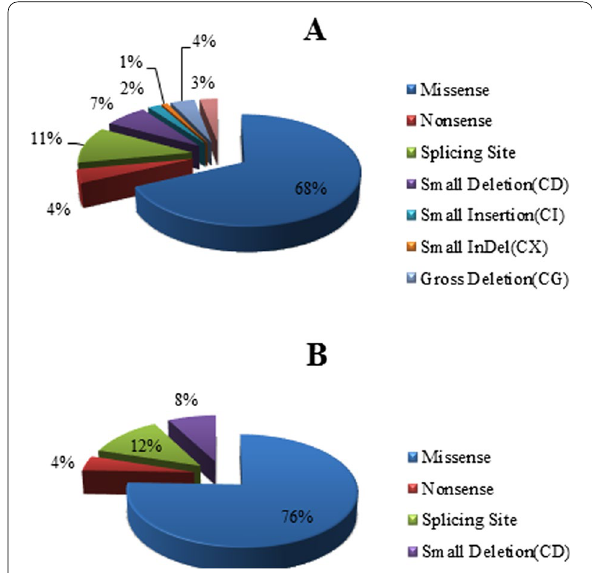
Fig. 3 The ATRX gene mutation types reported to date in ATR-X syndrome ( A ) and ATMDS ( B